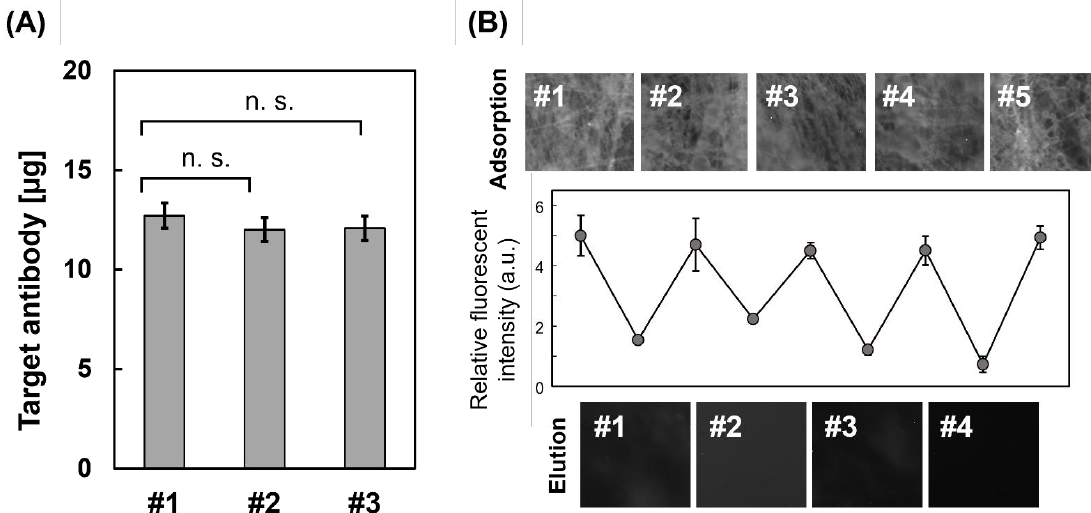
Figure 8. Successive repetitive adsorption-elution processes. ( A ) Amounts of antibody eluted ( n = 3, n.s.: no significant difference), ( B ) Fluorescent microscopy of CA/PVA-PA NF, which were adsorbed with fluorescent-labeled IgG. The graph represents the quantitative evaluation of fluorescent intensity.